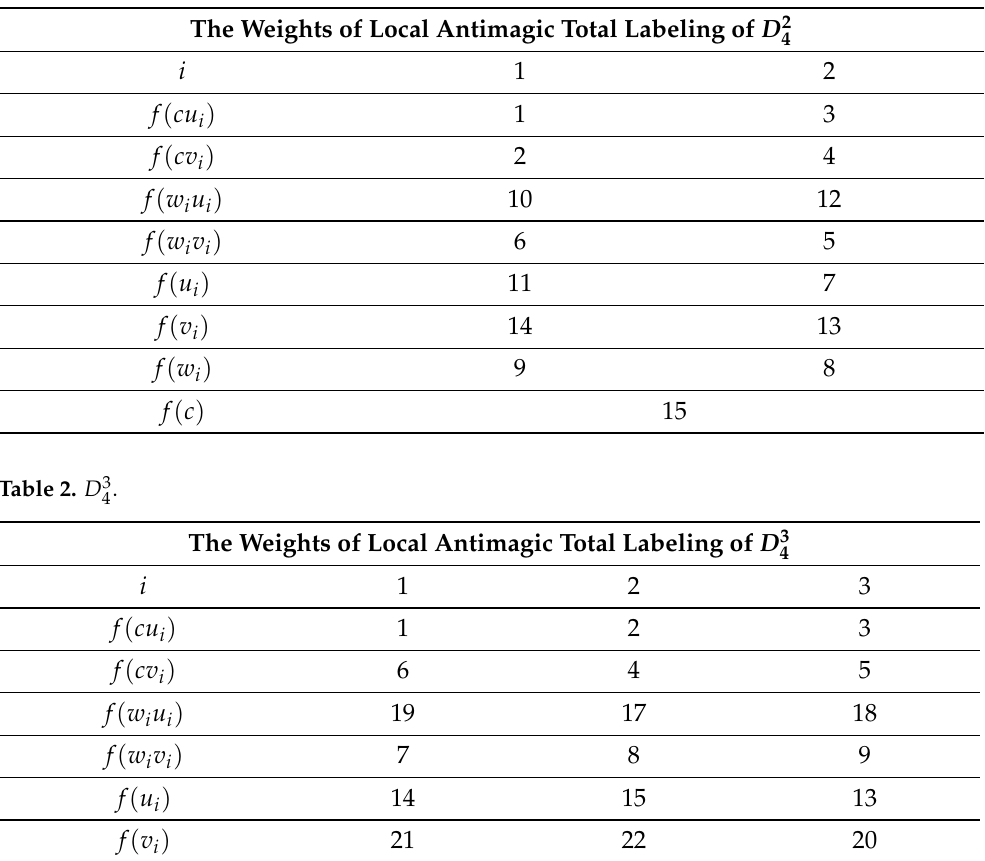
Table 1. D 2 . 4 The Weights of Local Antimagic Total Labeling of D 2